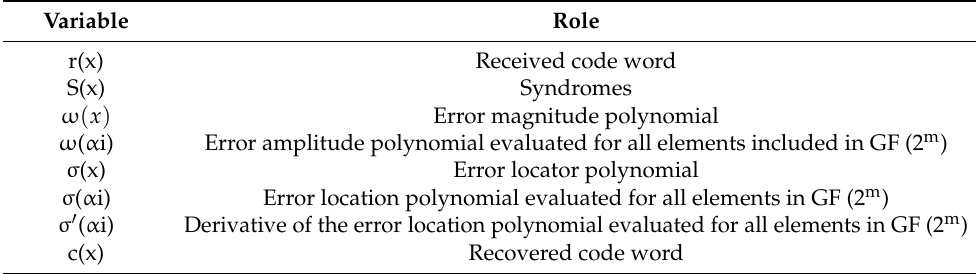
Table 1. Decoding